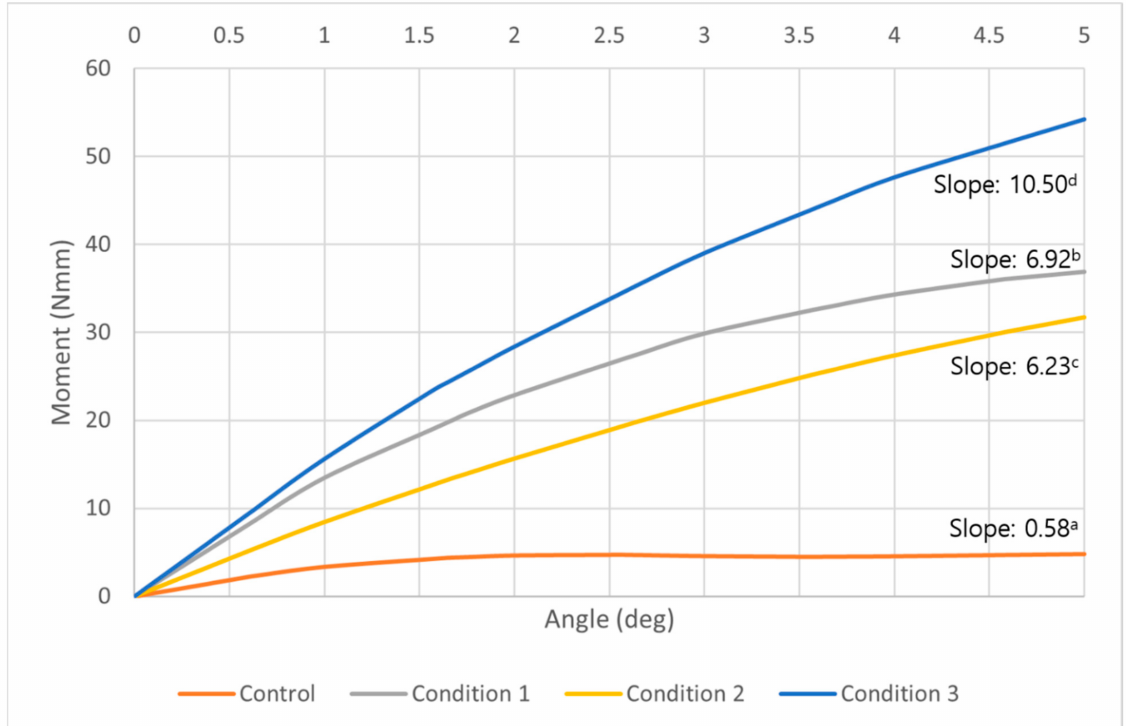
Figure 6. A graph of the overall moment required to unwind the orthodontic miniscrew at each degree of counterclockwise rotation in control (orange), condition 1 (gray), condition 2 (yellow), and condition 3 (blue). While the models of all conditions showed a constant increase of the moment, the control showed an increase by 2 degrees of counterclockwise rotation, but a plateau appeared from 2 degrees to 5 degrees of the counterclockwise rotation. The highest moments were measured at every angle in condition 3 model. a,b,c,d Different alphabets means statistically different slopes in control and each condition ( p <